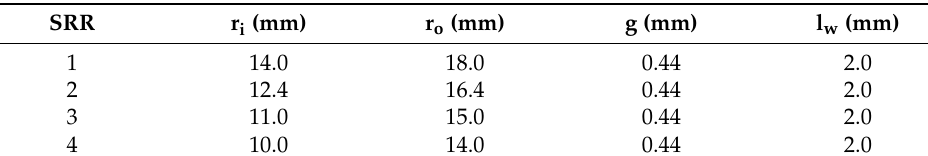
Table 1. Geometric dimensions of Split Ring Resonators. Figure 1. Split ring resonator geometry and its principal parameters.